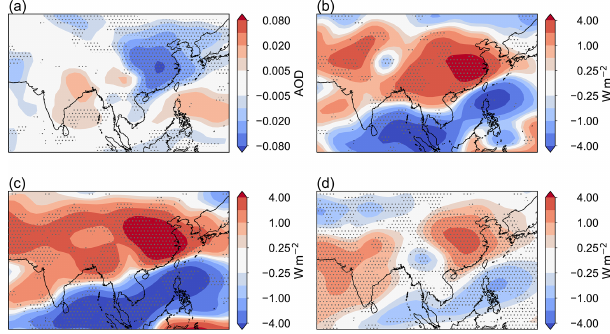
Figure 2. Spatial patterns of MEM anomalies in (a) AOD at 550nm, (b) all-sky net top-of-atmosphere (TOA) SW radiation, (c) all-sky surface downwelling SW radiation and (d) clear-sky sur- face downwelling SW radiation for JF 2020. Stippling indicates where at least 70% of the models agree on the sign of